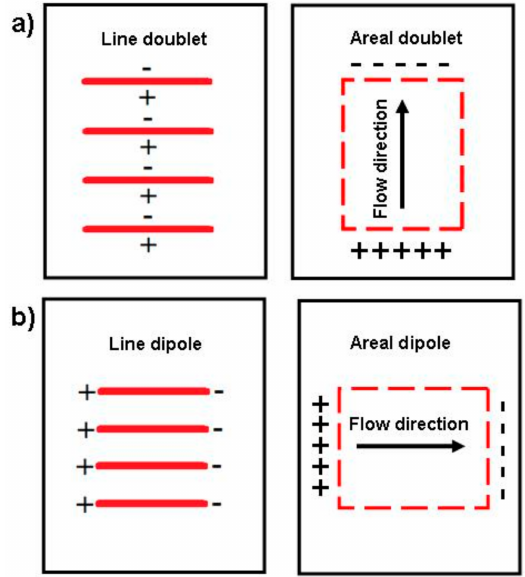
Figure 12. Visualization of ( a ) areal doublet, and ( b ) areal dipole. ( a , b ) are obtained by superposing an infinite number of line doublets and line dipoles,